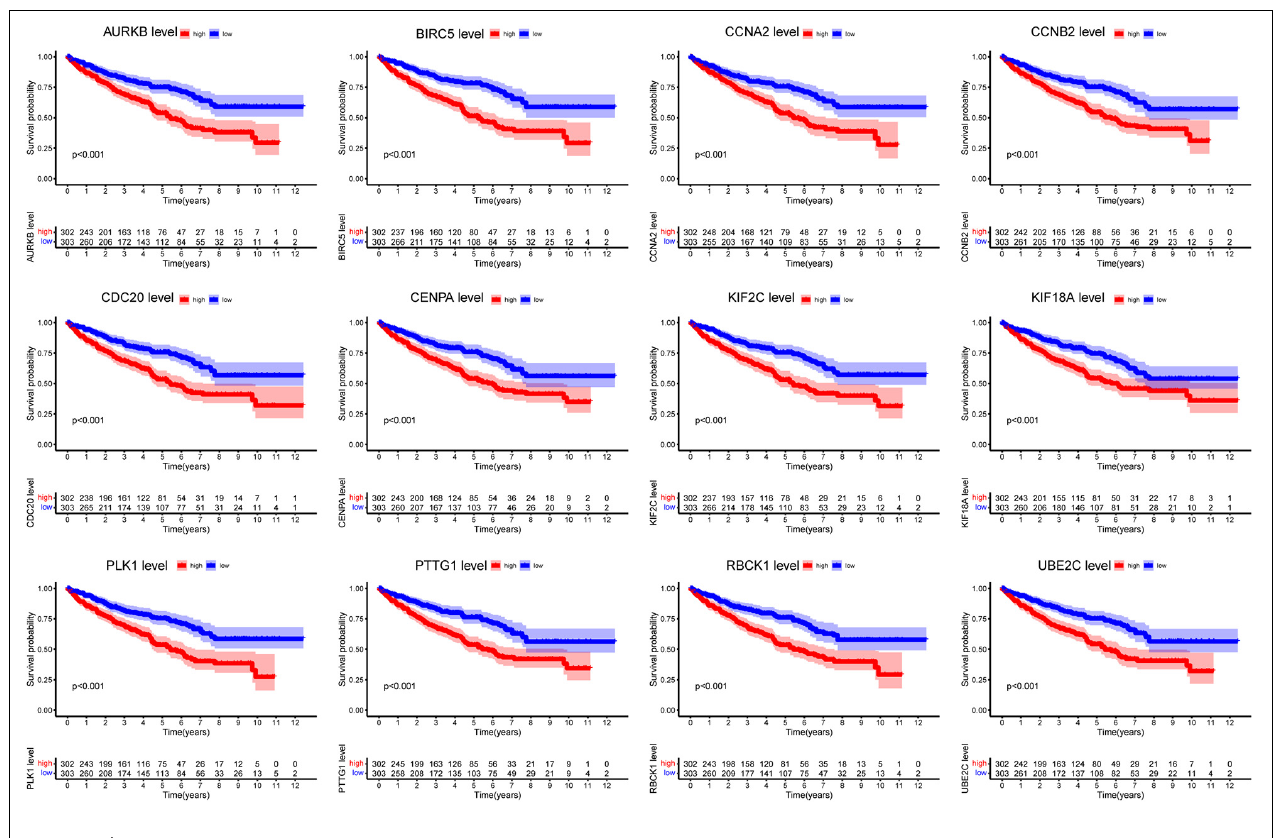
FIGURE 2 | Overall survival analysis of all seed